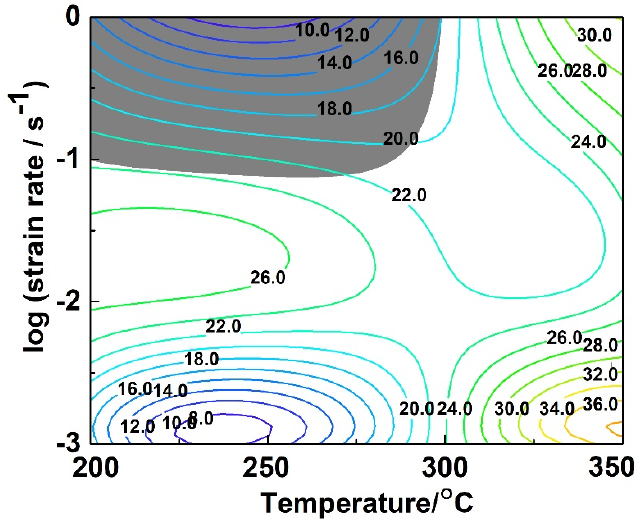
Figure 6. Processing map of Mg-3Sn-2Al-1Zn-0.6Nd alloy at the strain of 0.8.